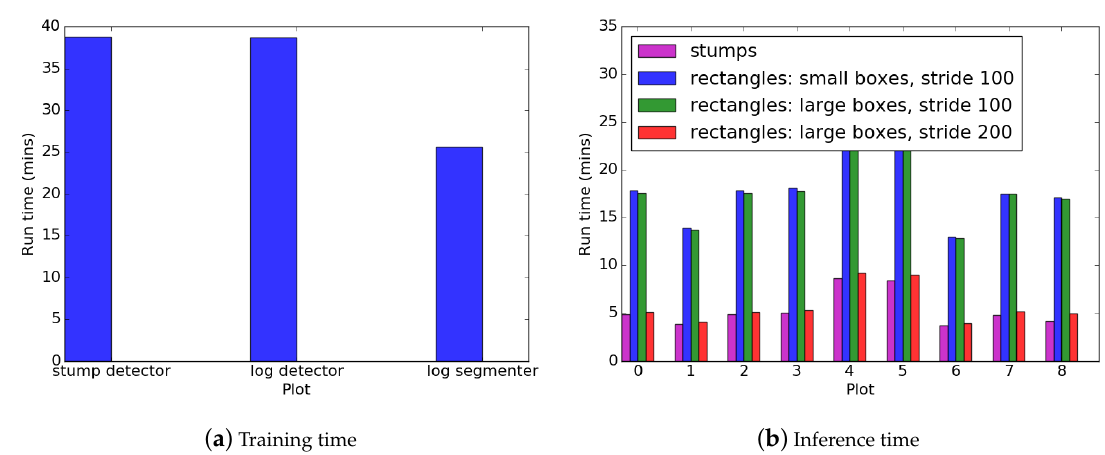
Figure 14. The runtime results for ( a ) training and ( b ) inference, averaged over all folds. Please note that the log detector refers to training with the small boxes, while the stump detector contains the log detector trained on the large